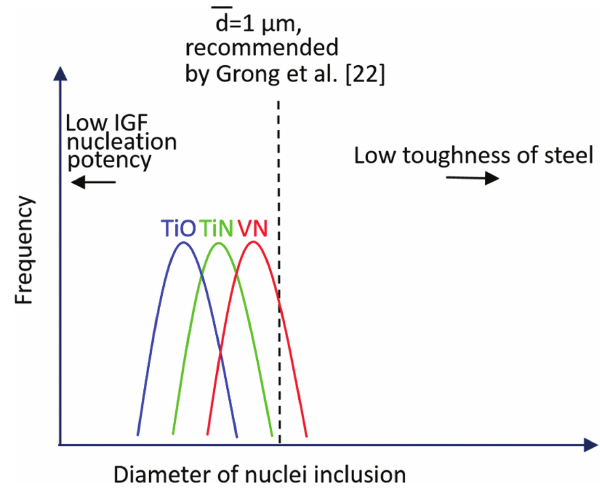
Figure 10: Schematic illustration of optimized size distribution of nuclei inclusions in